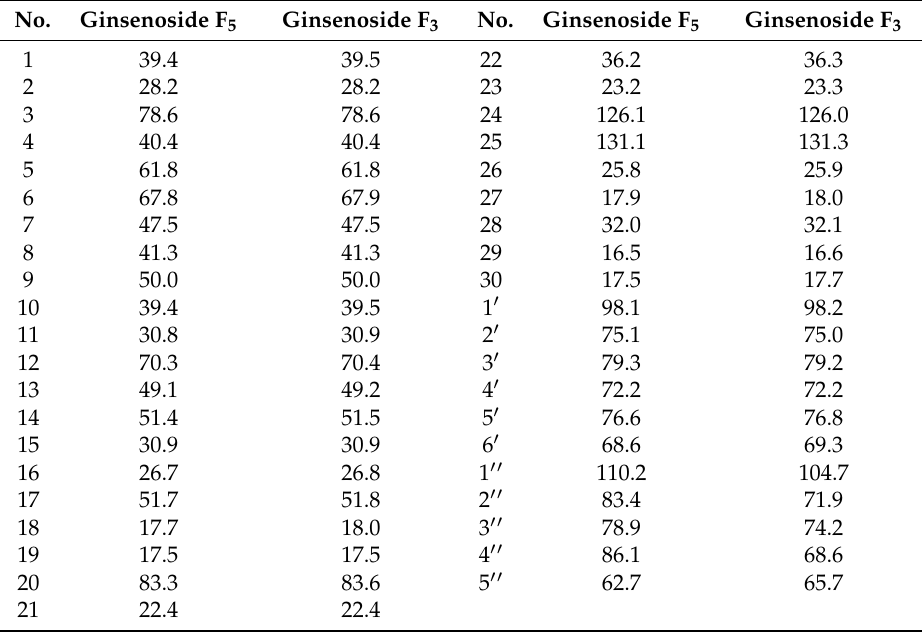
Table 3. 13 C-NMR data of ginsenoside F 5 and F 3 in pyridine- d 5